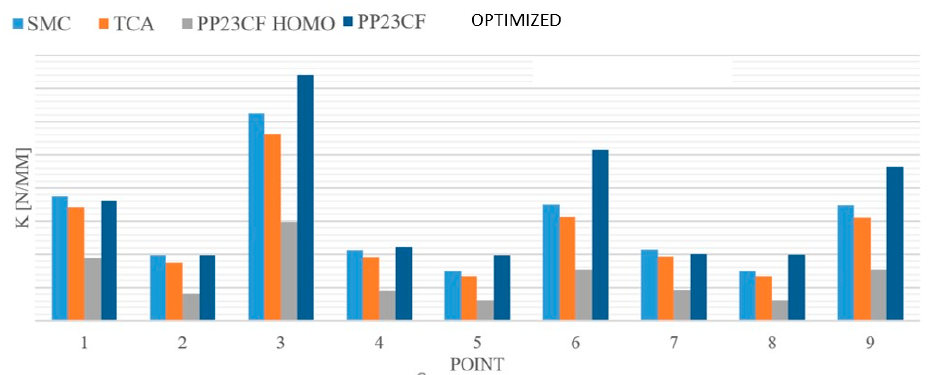
Figure 17. Static rigidity in the points of the car roof (Figure 11) for different materials (“PP23CF optimized” makes reference to the new stiffened configuration).